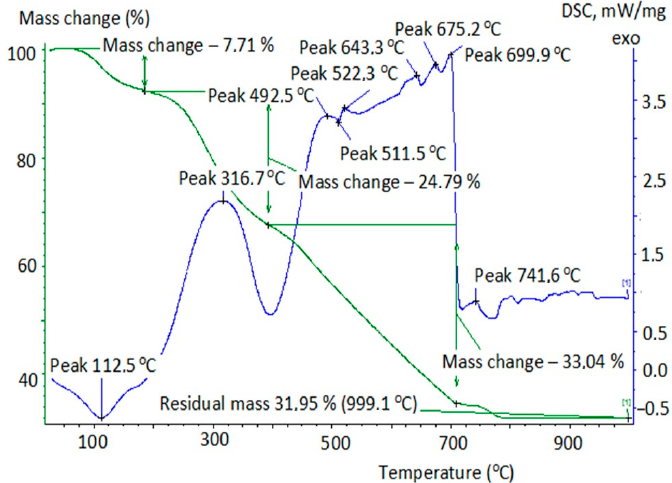
Figure 1. Thermogram of initial iron-containing peat composite.